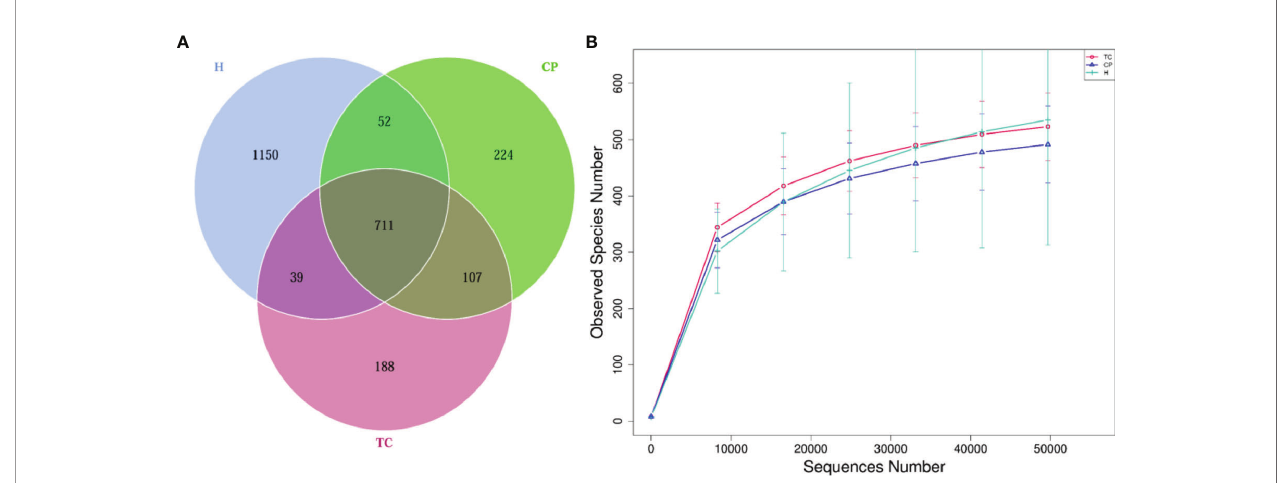
FIGURE 1 | Venn diagram and rarefaction curve diagram. (A) Venn diagram. Each circle in the fi gure represents a group, the numbers in the overlapping parts of the circles and the circles represent the number of operational taxonomic units (OTUs) shared among the samples (groups), and the numbers without overlapping parts represent the unique OTUs of the groups. (B) Rarefaction curve diagram. The abscissa is the number of sequencing strips randomly selected from a sample, and the ordinate is the number of OTUs that can be constructed based on the number of sequencing strips. Different groups are represented by curves with different